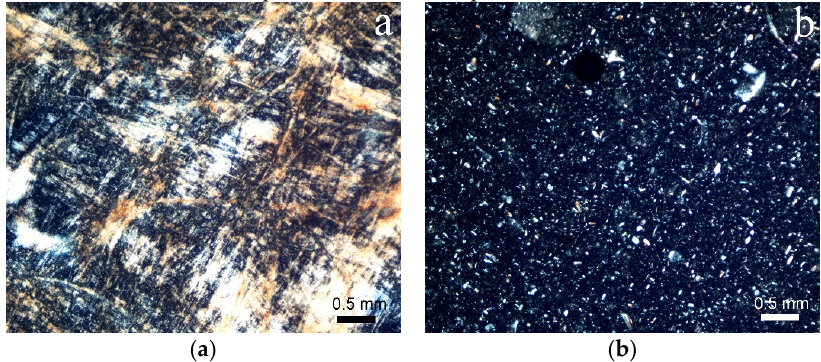
Figure 4. Micrographs in crossed Polaroids of 1.23% BC ( a ) and 5% NCC ( b ) dispersions.